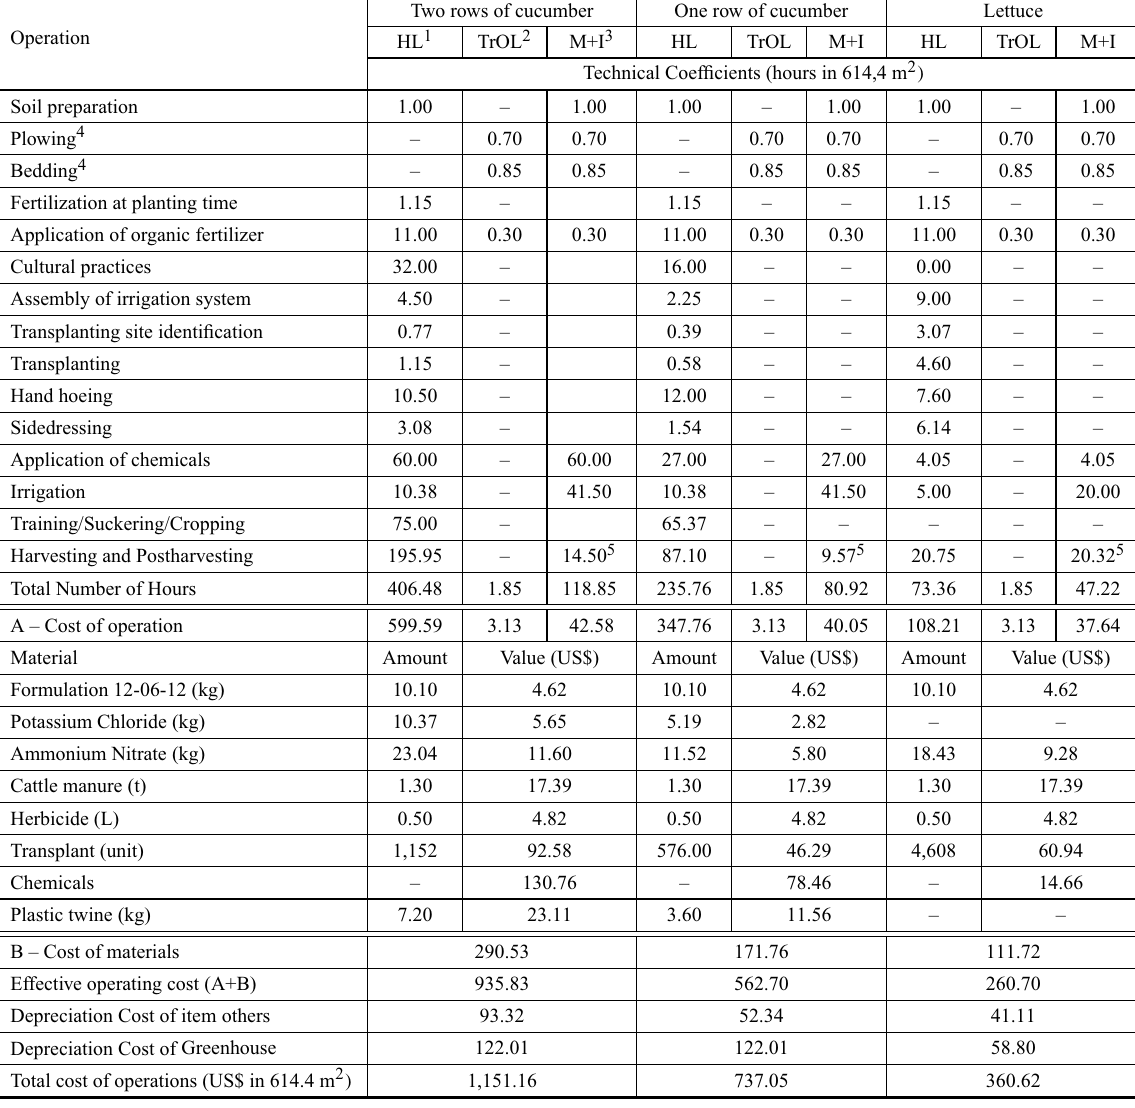
Technical coefficient and total cost of operations in dollars (US$) for August 2007, for the production of Japanese cucumber ‘Hokushin’ with two and one row on the bed and lettuce in sole crop, under protected cultivation of 614.4 m 2 . Jaboticabal, SP, Brazil, 2007. Two rows of cucumber